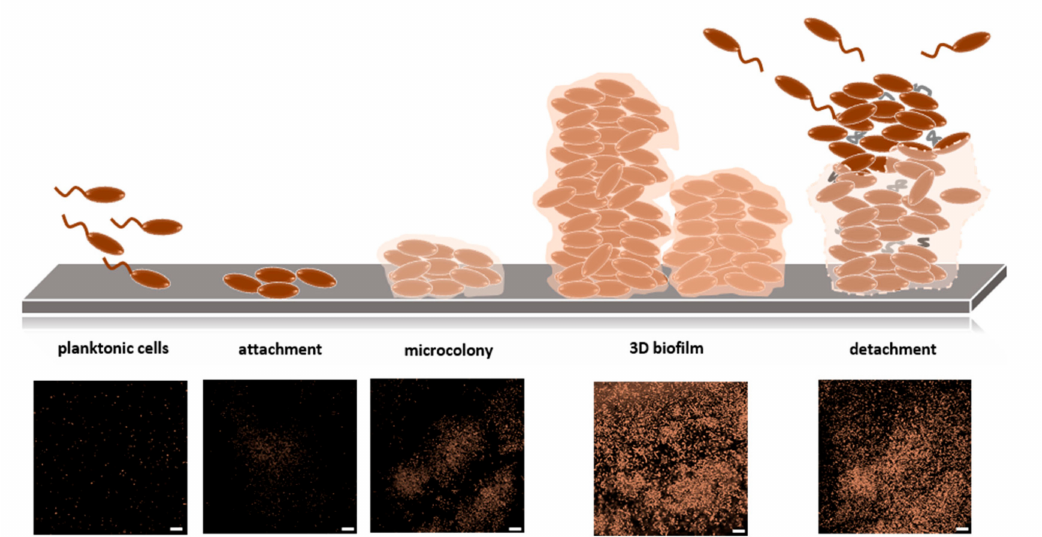
Figure 5. Biofilm development. (Upper panel) Free-swimming bacteria initially attach to a solid surface, and colonizing bacteria further form structured aggregates called microcolonies. Biofilms are composed of numerous microcolonies, which are encased in an extracellular polymeric matrix. Biofilms permanently undergo composition/decomposition.